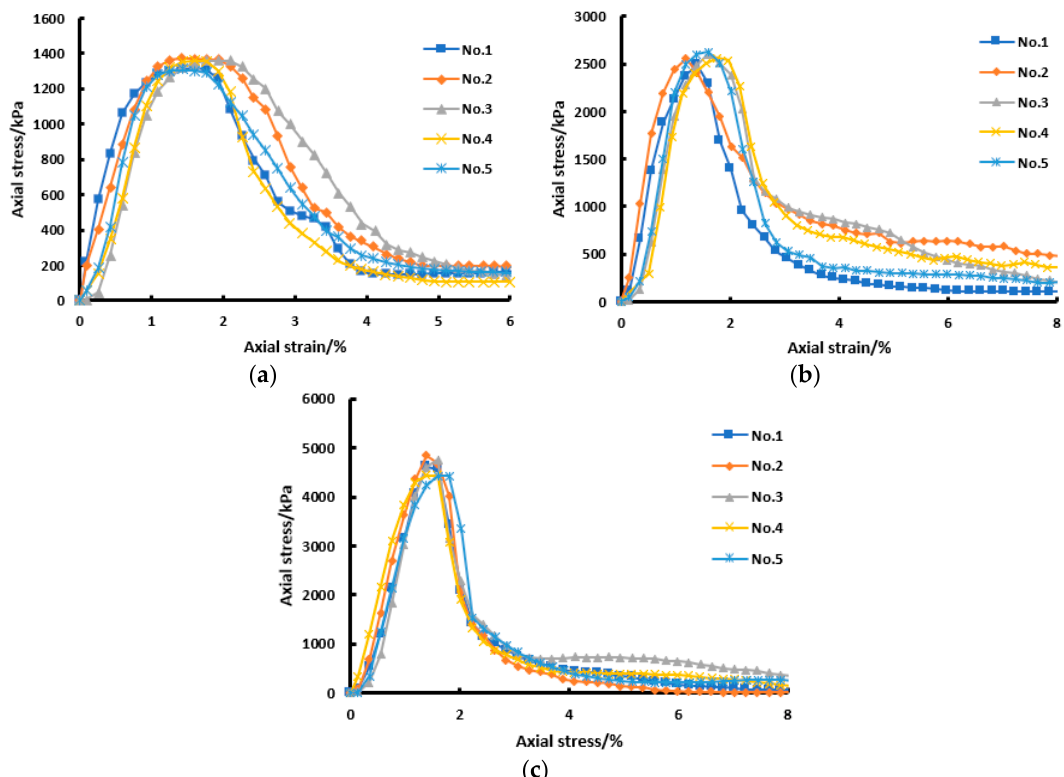
Figure 10. Stress–strain curve of STCS. (a) STCS-0.5-20; (b) STCS-1.5-20; (c) STCS-2.5-20